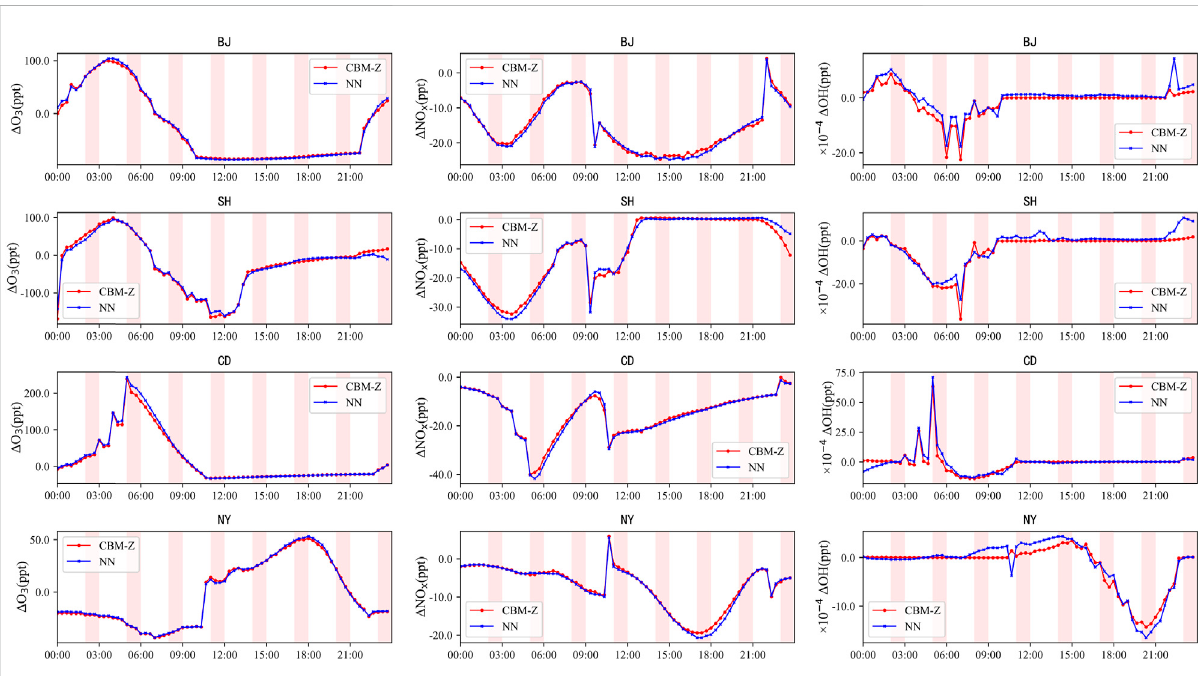
FIGURE 7 Diurnal variation diagram of CBM-Z and neural network (NN) emulator simulation effect in four cities (Bei Jing, BJ; Shang Hai, SH; Cheng Du, CD;NewYork,NY)at100 mabovegroundlevel.Theredshadedpartisthepredictioneffectoftestingdataset,andtheotherwhiteshadedpartisthe prediction effect of training dataset. The red broken line represents the simulated diurnal concentration change trend of CBM-Z module, and the blue broken line represents the simulated diurnal concentration change trend of the neural network